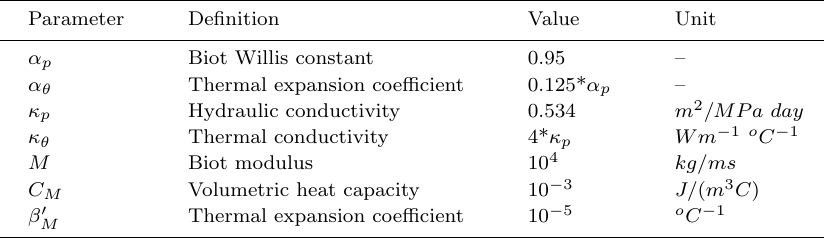
Table 1. Material parameters for the one-dimensional column